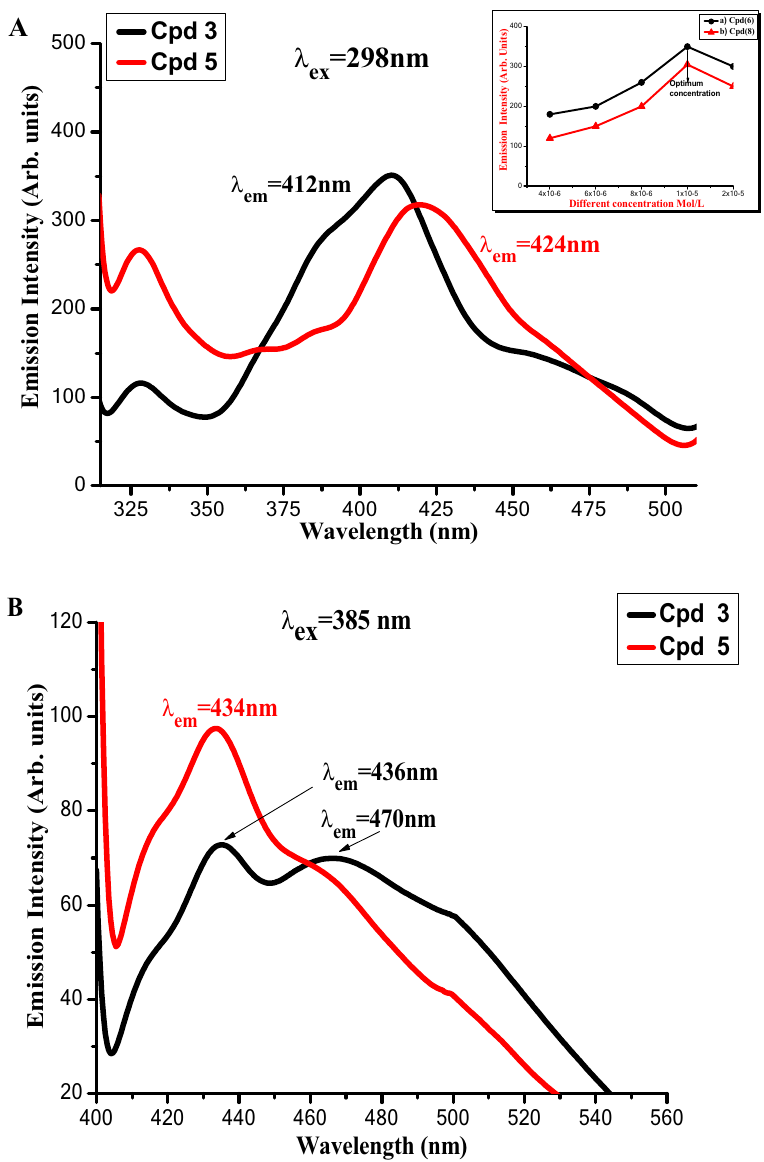
Figure 11. Emission of compounds 3 and 5 of concentration 1 × 10 −5 M in DMF A) at lower excitation λ ex = 298 nm (the inset figure is the emission intensities of different concentrations in DMF). B) At higher excitation λ ex = 385